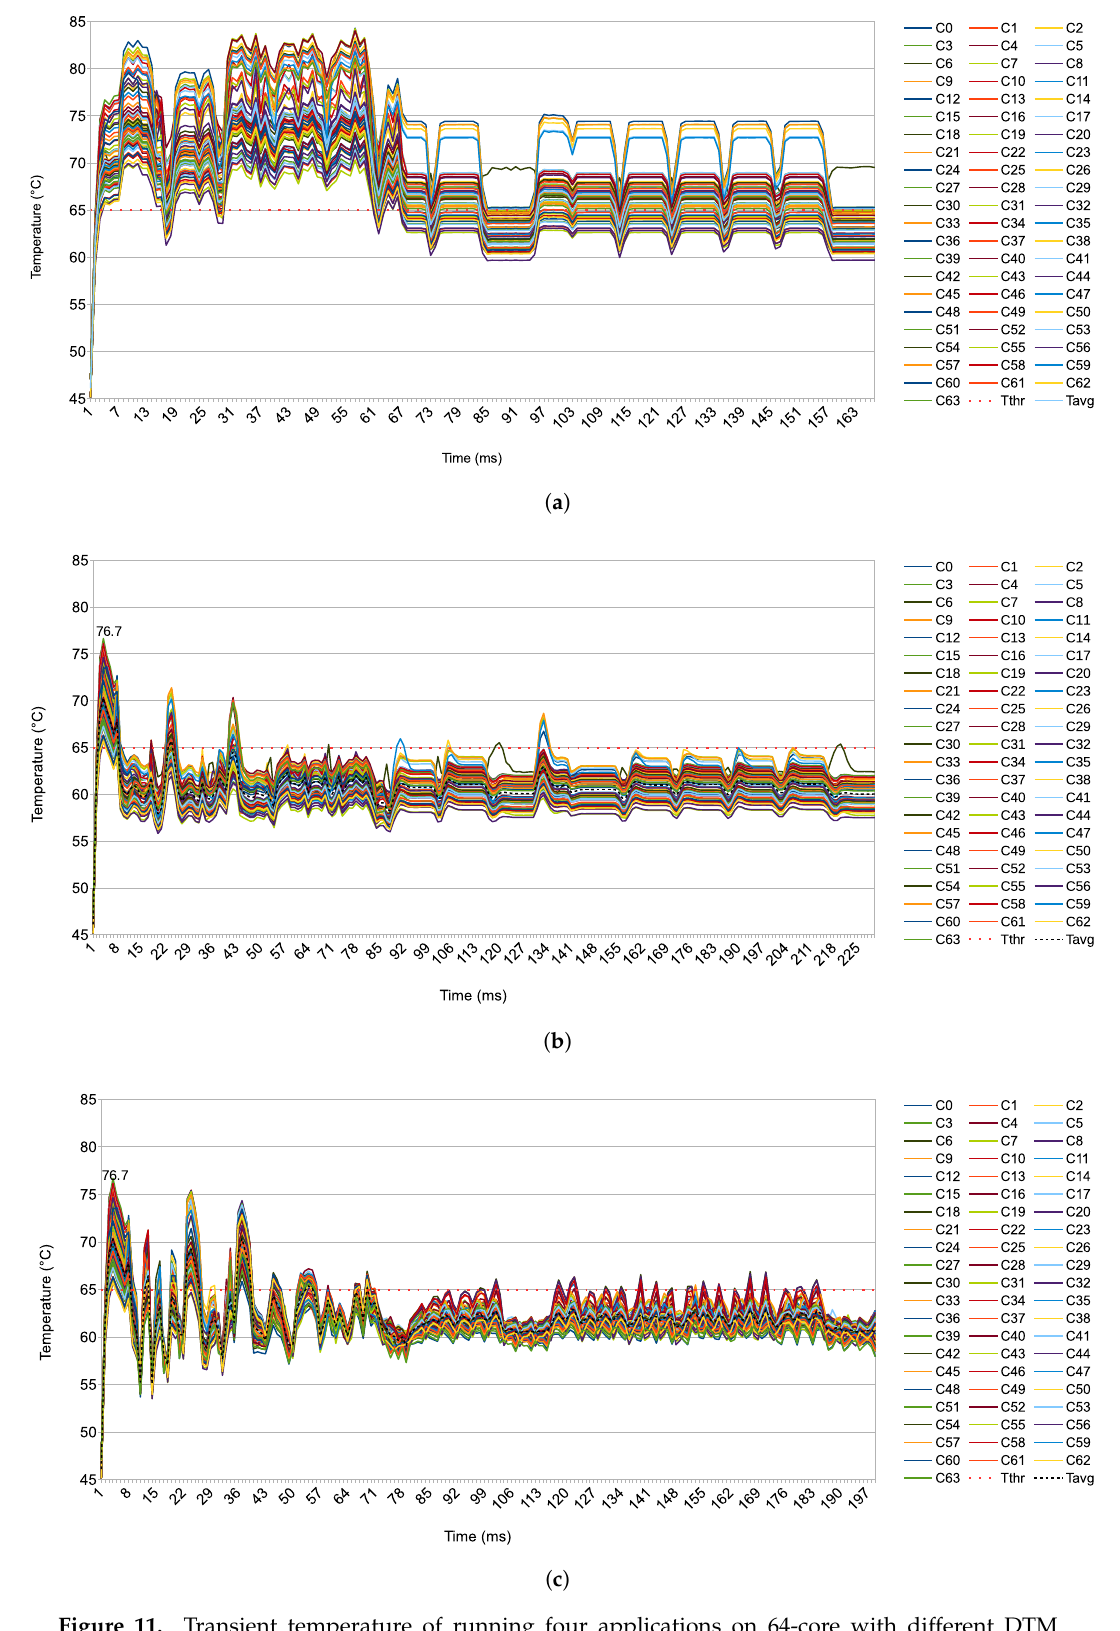
Figure 11. Transient temperature of running four applications on 64-core with different DTM techniques: ( a ) without DTM; ( b ) DVFS; and ( c )